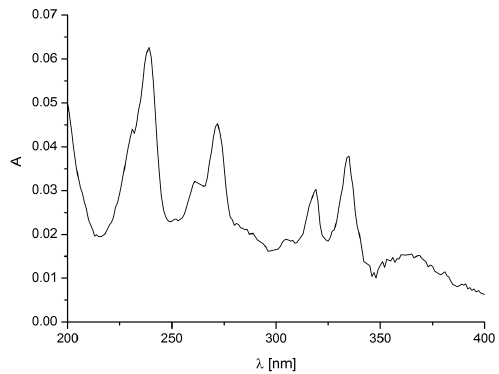
Figure 1. Absorption spectrum of pyrene in water (2 µM) at 25 °C.